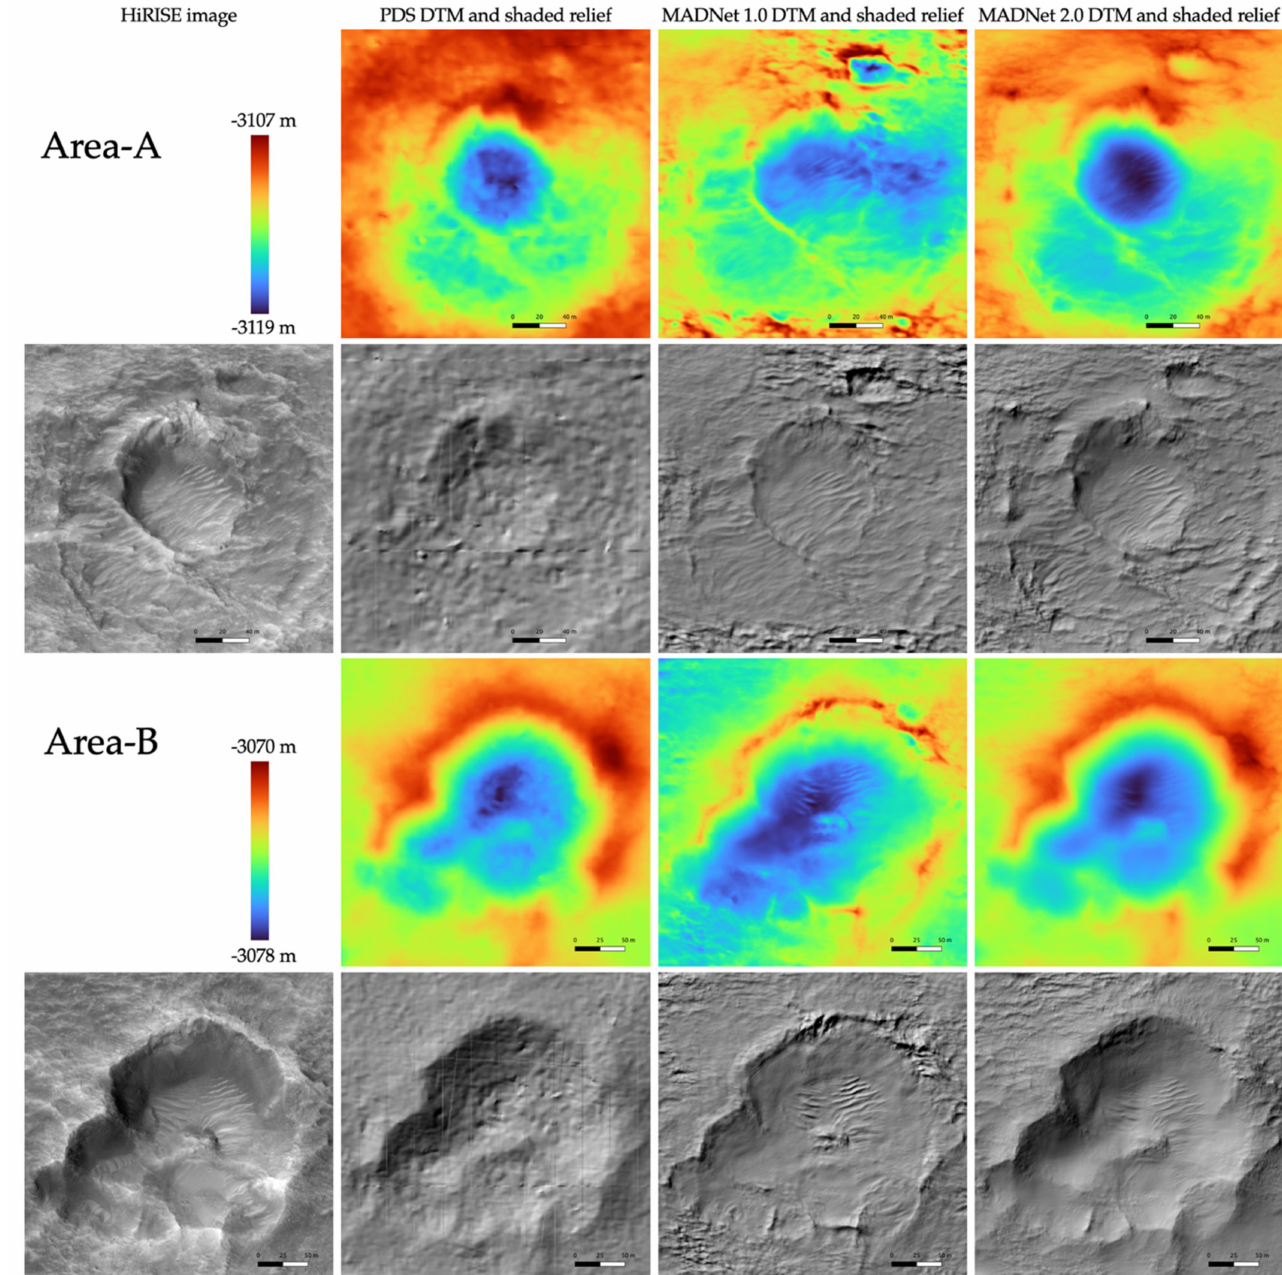
Figure 11. Examples of zoom-in views of the 1 m/pixel PDS HiRISE DTM, 50 cm/pixel MADNet 1.0 DTM, and 25 cm/pixel MADNet 2.0 DTM, produced from a single HiRISE image